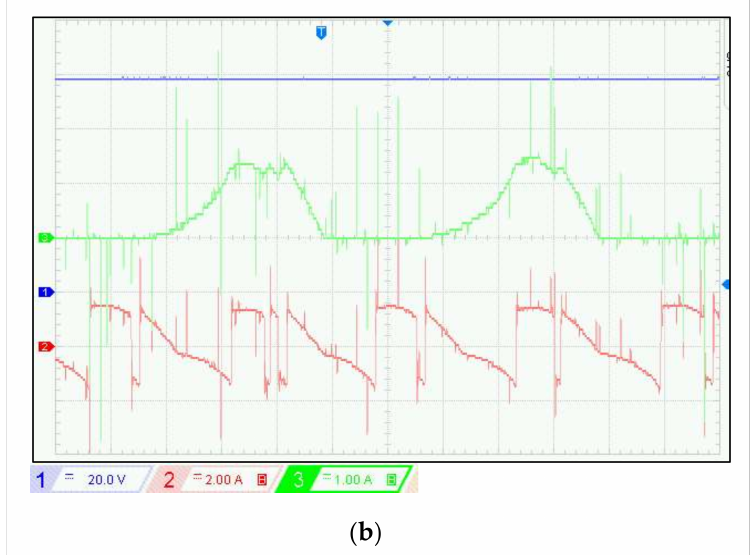
Figure 12. Experimental results of SRG: ( a ) Experimental waveforms of DC link voltage, phase current, and DC link current for different reference voltage at R L = 333 Ω and w = 600 rpm, ( b ) Zoom of Figure 12a at V DC-ref = 90 V.